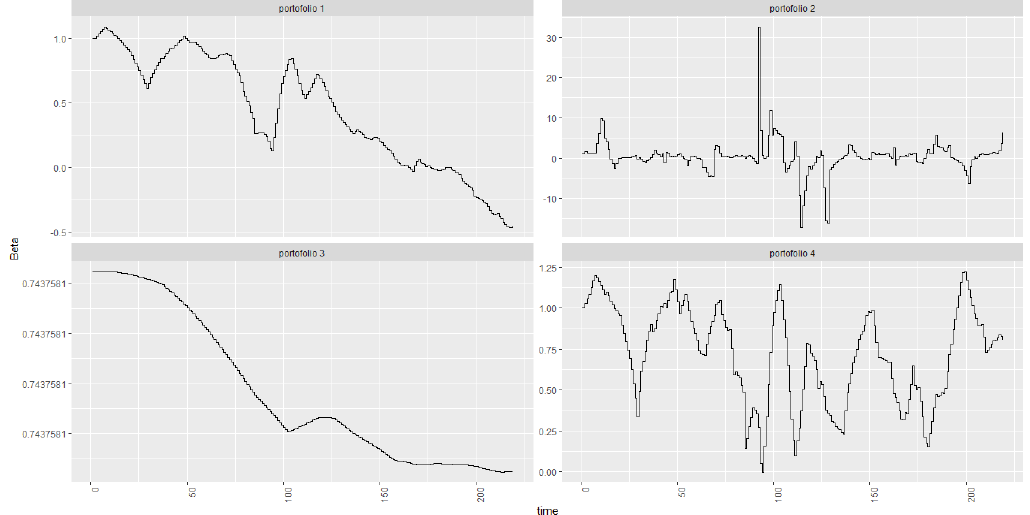
Figure A2. Beta estimated from the Kalman filter after the two-factor model. Source: author’s